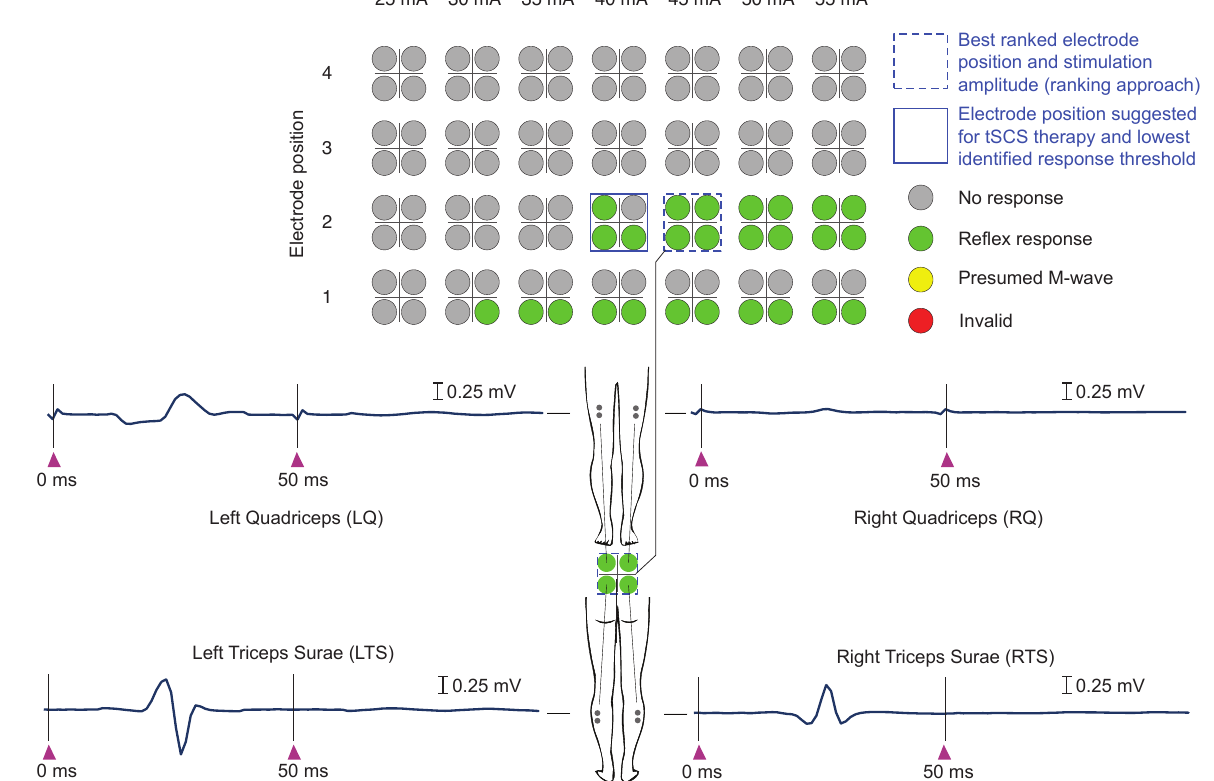
Figure 2. Rating light matrix derived for a neurologically intact individual, C1, along with EMG signals averaged from three repetitions of double stimulus application from electrode position 2 with a stimulation amplitude of 45mA (best ranked parameter combination). The four color-coded circles represent the results obtained for the four studied muscle groups per electrode position n and tested stimulation amplitude I (cf. Table 2). In favor of a compact overview, results are only displayed for the stimulation amplitude before the first detected response, in this case from 25mA instead of from 5mA, until the highest applied